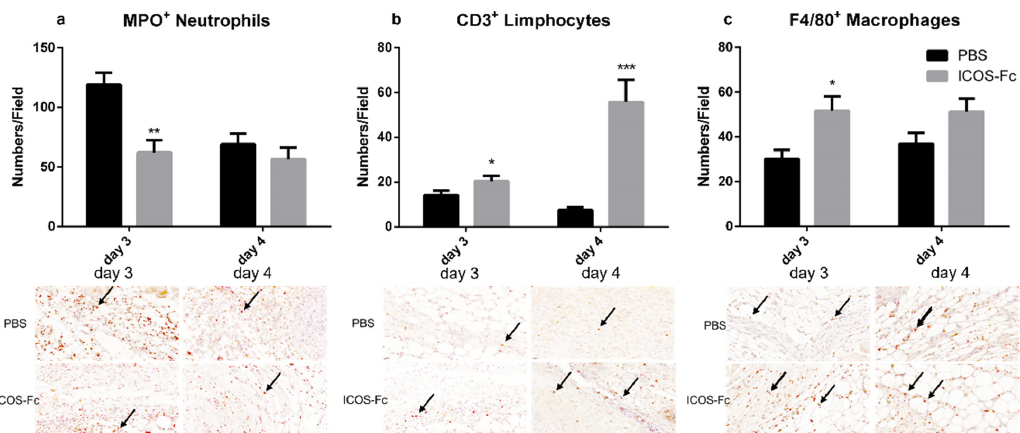
Figure 4. Effect of treatment with ICOS-Fc on the infiltration of inflammatory cells in the wound bed. Infiltration by neutrophils, T cells, and macrophages was assessed by immunohistochemistry using antibodies against MPO ( a ), CD3 ( b ), and F4/80 ( c ), respectively. Upper panels: number of positive cells per field counting 9 fields in each experiment at day 3 and day 4; results are expressed as mean ± SE. Lower panels: representative immunohistochemical staining (magnification 400×) at day 3. Statistical analysis was performed with Mann–Whitney test: * p < 0.05; ** p < 0.01; *** p < 0.0005.